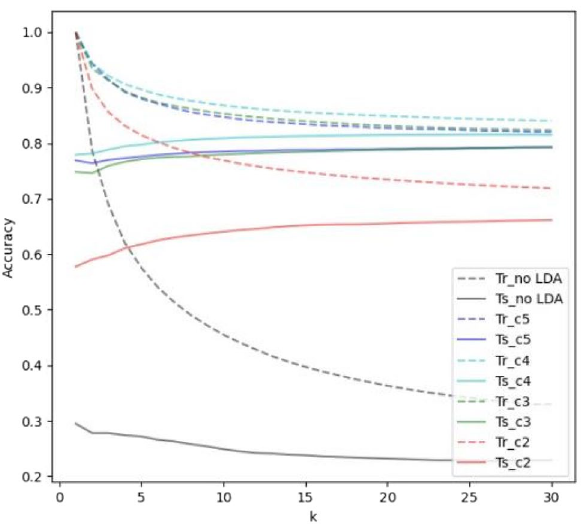
Figure 4. Result of snake image classification using k NN algorithm, as well as k NN in combination with a data dimension reduction approach (LDA), while k has been changing in a range from 1 to 30. The number of components (comp) was ranging from 2 to 5.